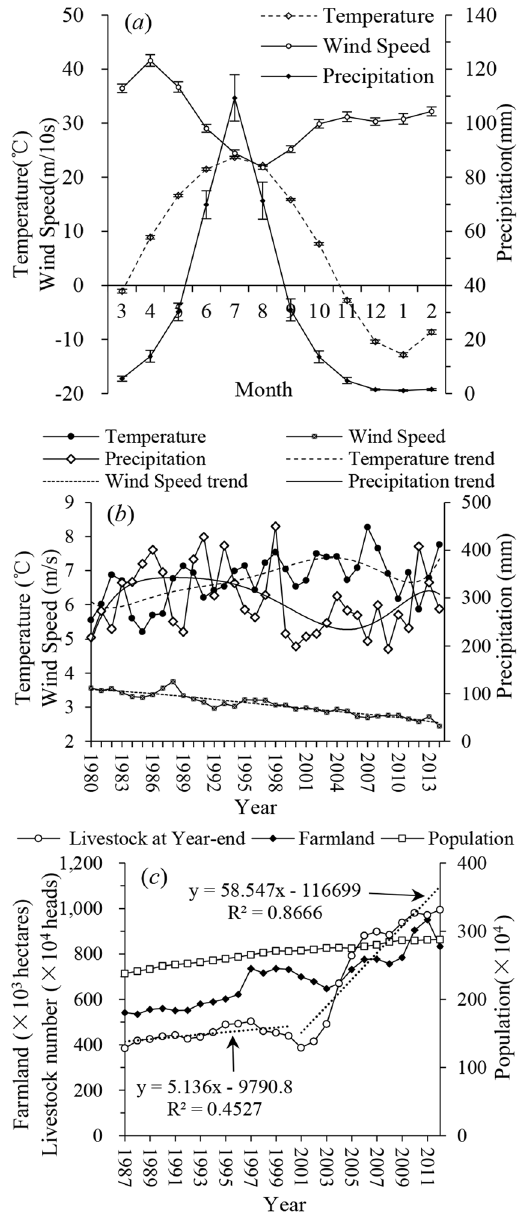
Figure 3. Trends of climatic and human-related factors in the study area. The meteorological data are averaged values from the weather stations in Ongniud, Naiman, Jarud, Barin left and Tongliao, and the socioeconomic data are the averaged values of the statistic almanac data from these banners. ( a ) is the monthly averaged value and its standard deviation from 1980 to 2014. ( b ) and ( c ) are the annual average